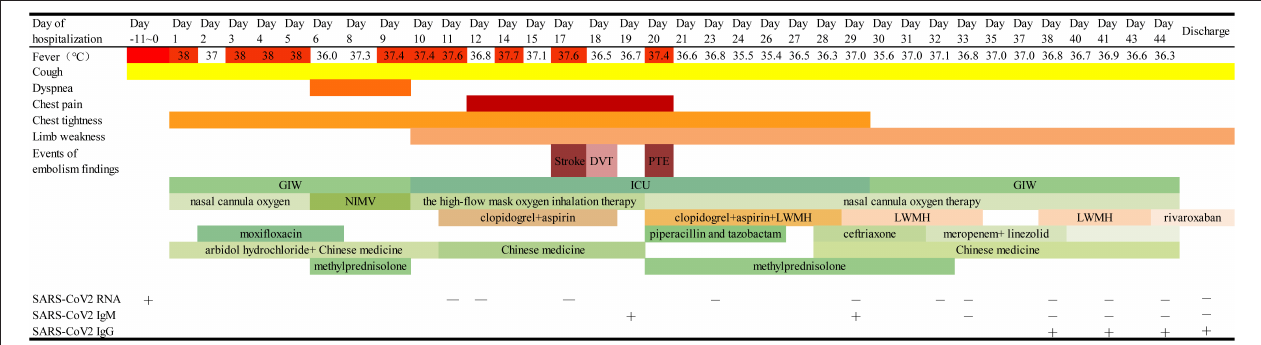
FIGURE 1 | Timeline of disease course according to days from admission, and days of follow-up from February 13 to March 27, 2020. ICU, intensive care unit; GIW, general isolation ward; NIMV, non-invasive mechanical ventilation; LMWH, low-molecular-weight heparin; DVT, deep venous thrombosis; PTE: pulmonary thromboembolism.